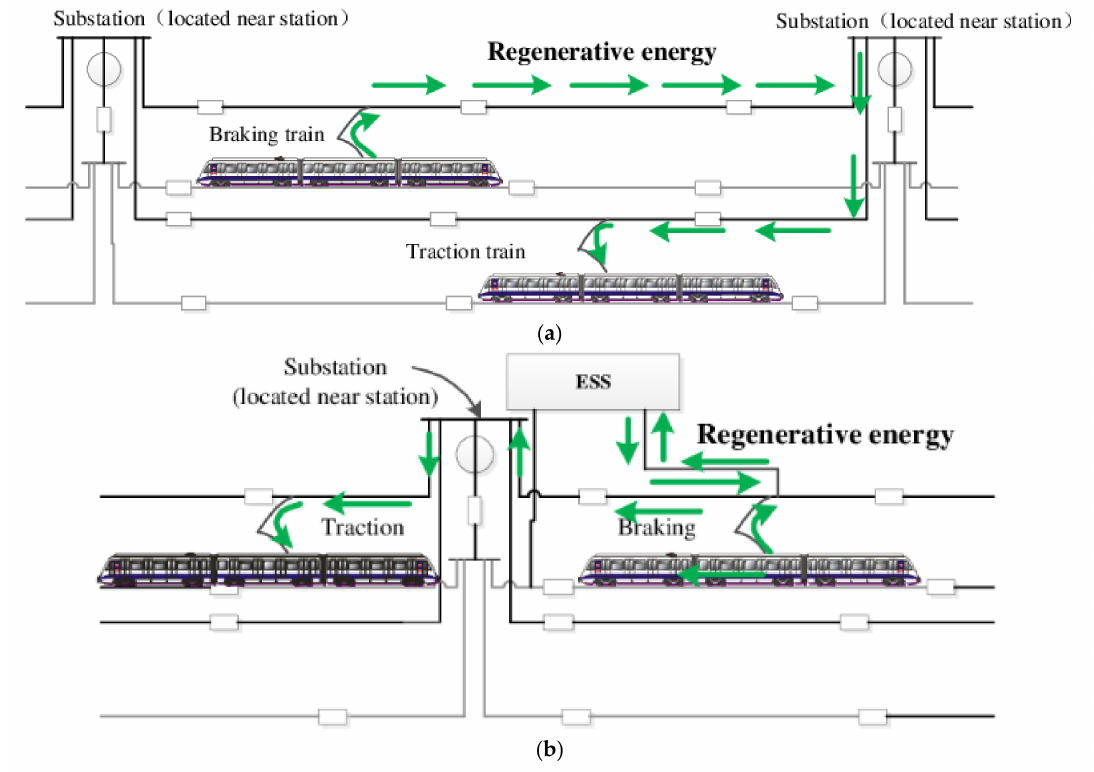
Figure 1. Recovery of braking energy: ( a ) reversible substations (RSSs); ( b ) energy storage systems